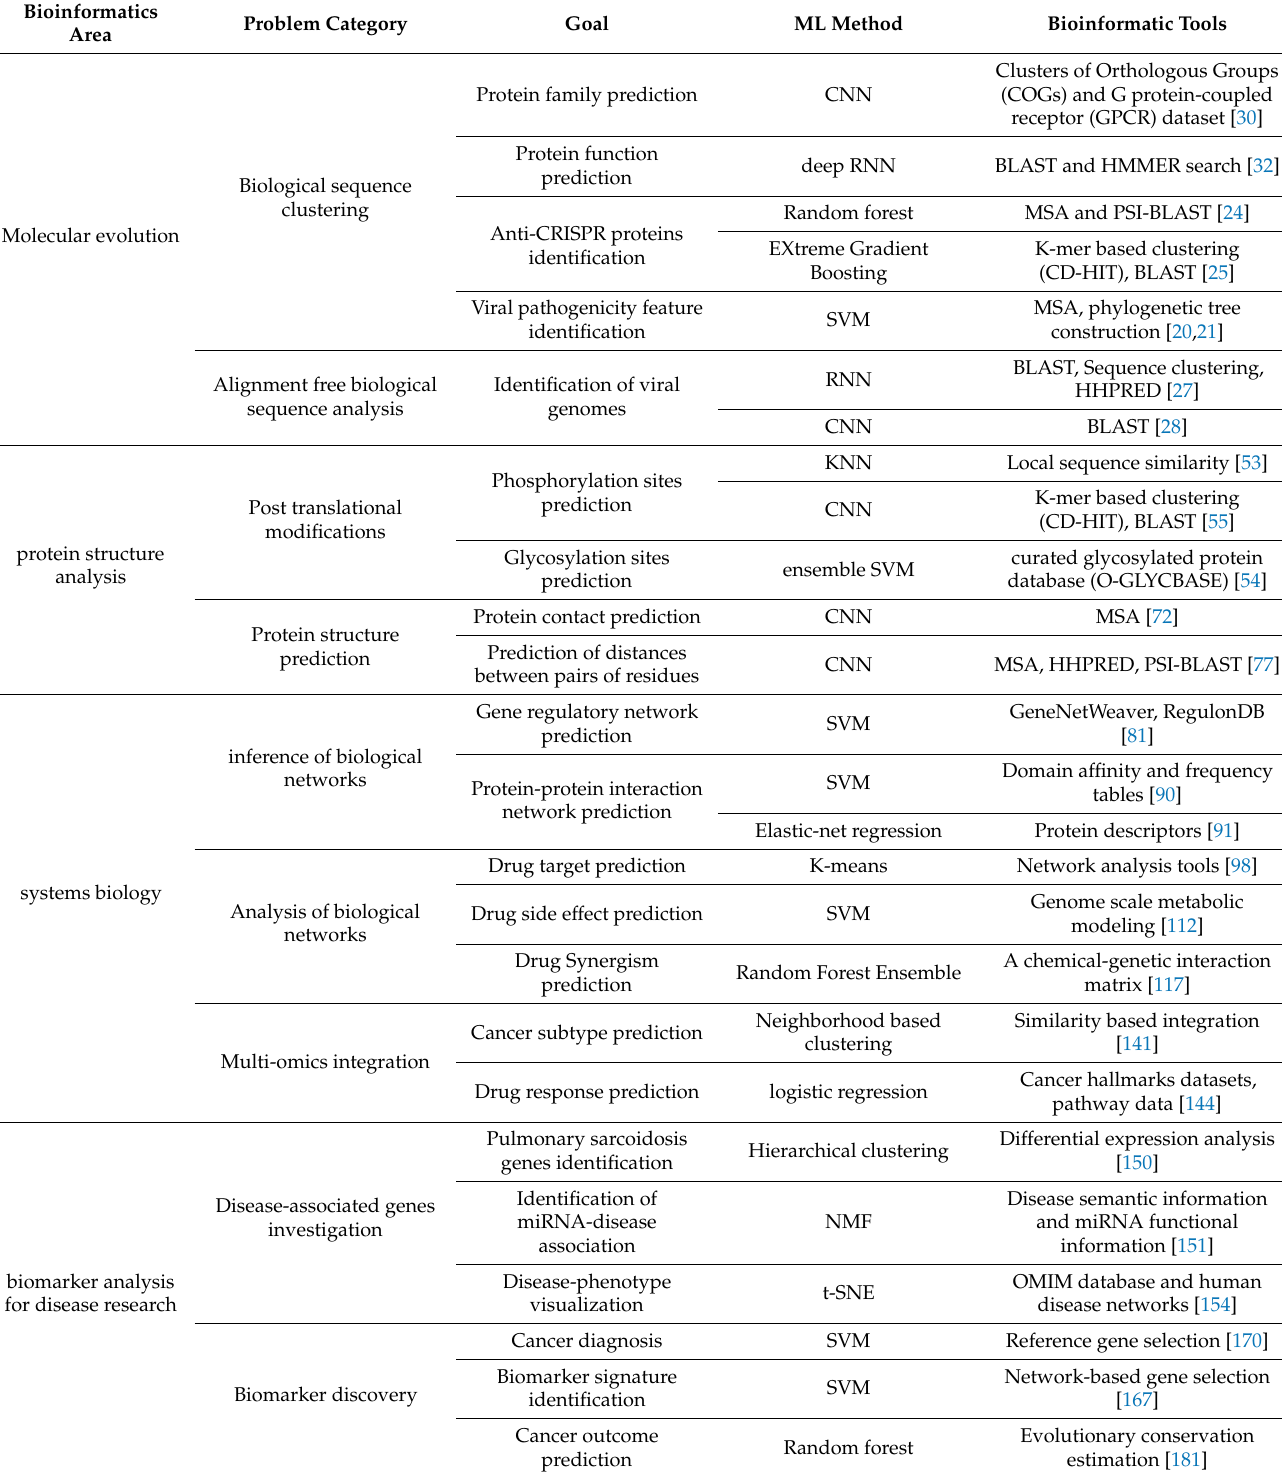
Table 1. Representative problems and methods addressing them by incorporating machine learning (ML) with bioinformat- ics tools in four